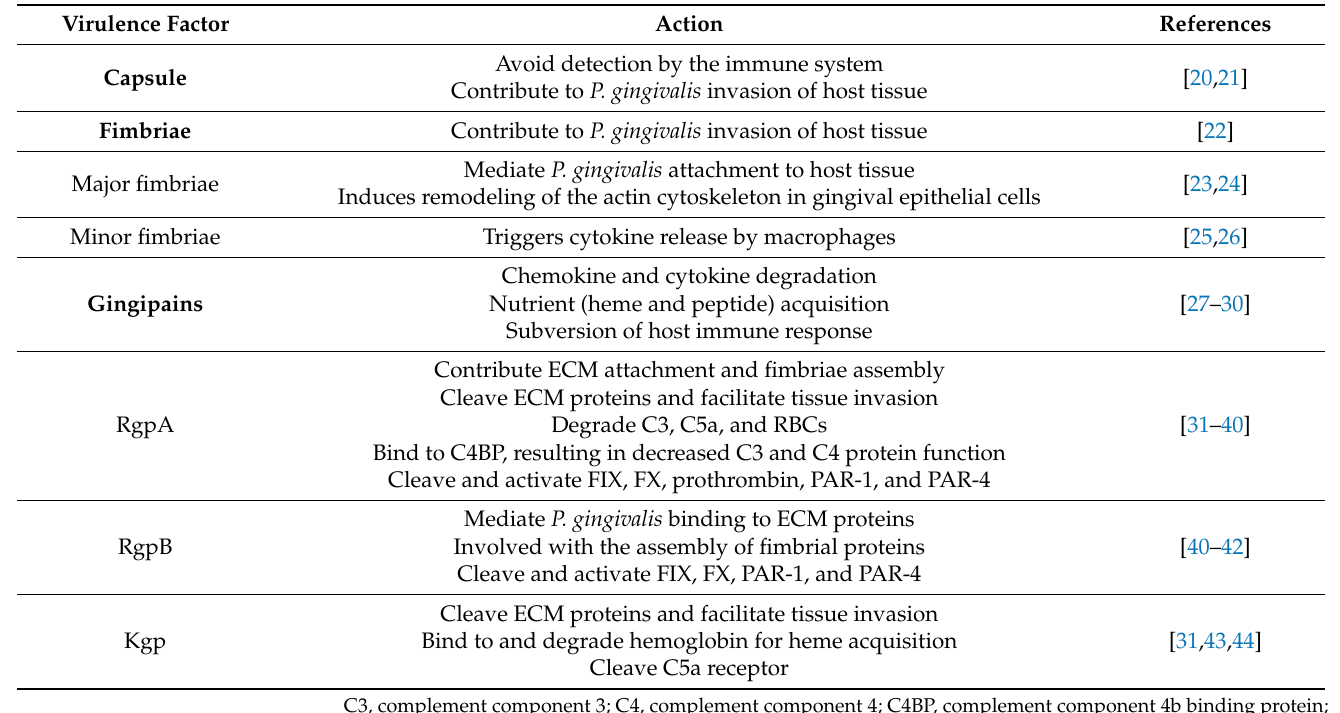
Table 1. Virulence factors produced by Porphyromonas gingivalis